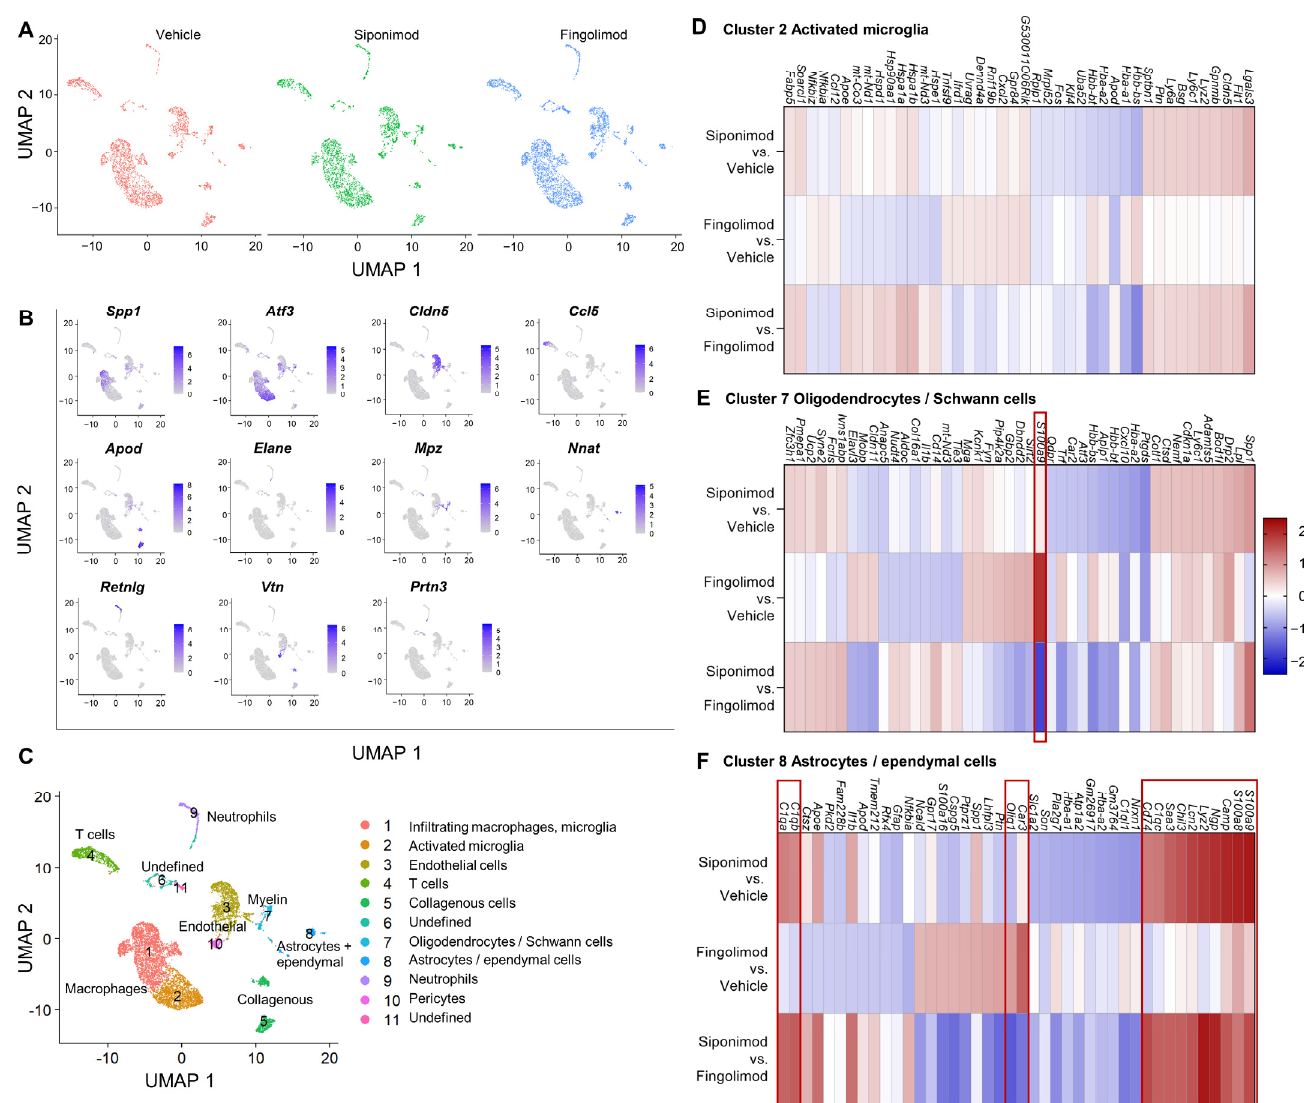
Figure 9. Single-cell RNA sequencing of spinal cord from chronic experimental autoimmune en- cephalomyelitis (EAE) mice. The spinal cord was digested mechanically and enzymatically, and mRNA from single cell suspensions was analyzed using scRNA-seq. ( A ) UMAP clustering with a resolution of 0.1 revealed 11 different clusters evenly detected in all three treatment groups. ( B ) Top genes expressed by each cluster. ( C ) Clusters were classified, according to marker genes. ( D – F ) Dif- ferentially expressed mRNA between treatment groups of clusters 2 ( D ), 7 ( E ) and 8 ( F ). Heatmaps show the 10 genes with the greatest difference in each comparison in both directions (up- and down- regulation). Genes with a logFC >|1.5| are highlighted by red boxes. ScRNA-seq = single cell RNA sequencing, logFC = log(fold change); UMAP = uniform manifold approximation and